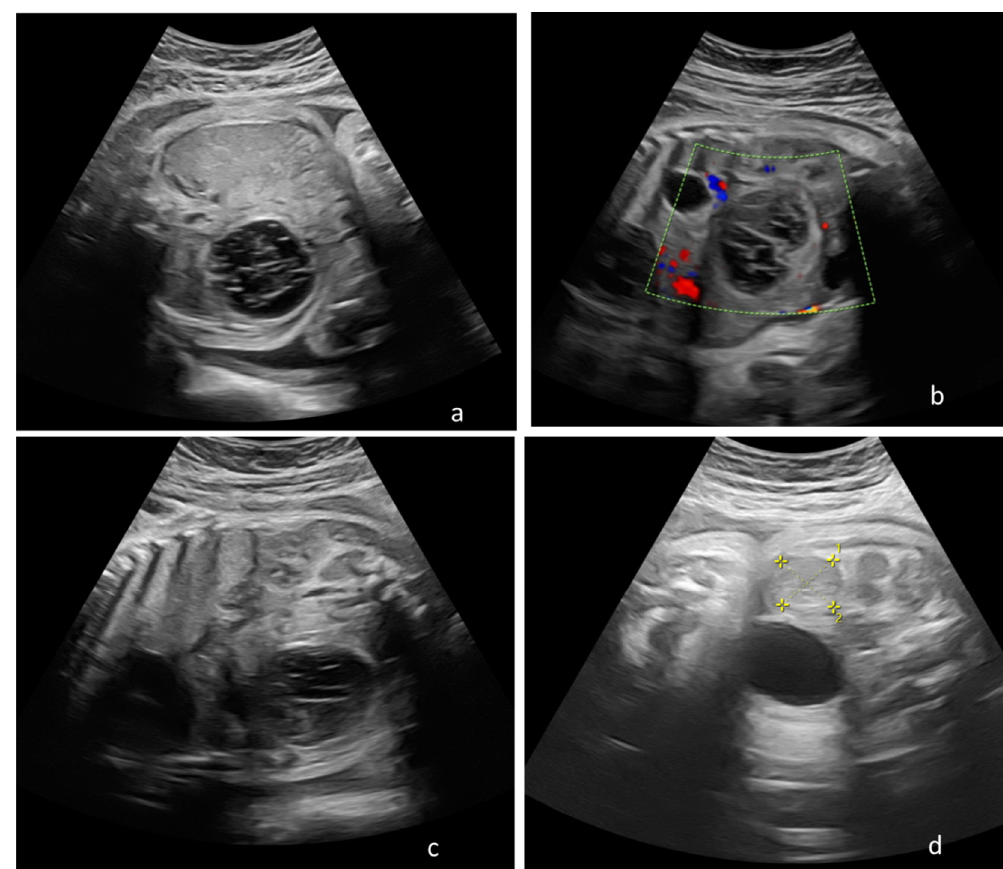
Figure 3. Consecutive prenatal ultrasonography depicting transformations of a fetal ovarian cyst that presented postnatal resorption, discovered at 31 weeks of gestation, and follow up until 36 weeks of gestation in a woman diagnosed with severe preeclampsia. ( a ) Thirty-one weeks of gestation female fetus with an 3 cm diameter echogenic right ovarian cyst with a thing wall, suggesting intracystic hemorrhage; ( b ) 32 weeks and 4 days, the changes of the cyst are followed, which becomes elongated, keeping the appearance of a intracystic hemorrhage, measuring 4.5/4 cm; ( c ) same case at 33 weeks and four days the fetal cystic begins to clarify its contents and maintains its decreases it diameter at 4.5/3.5 cm ( d ) same case at 36 weeks and four days, the fetal cyst is in important resorption measuring 2.32/2.39 cm. Figure 3a,c,d represent B-mode ultrasound images, while Figure 3b is CFM (Colour Flow Mapping) ultrasound mode that shows peripheral blood flow.